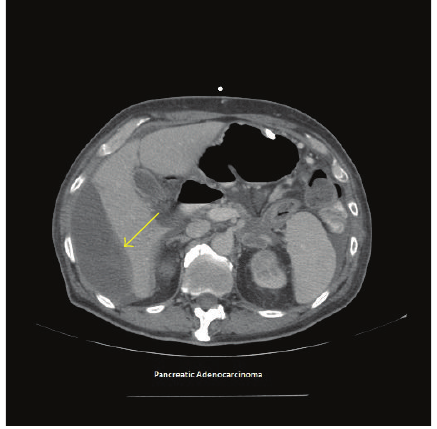
Figure 1: Axial contrast enhanced CT image showing metastasis in liver dome (large yellow arrow) had grown since earlier study (Figure 2).